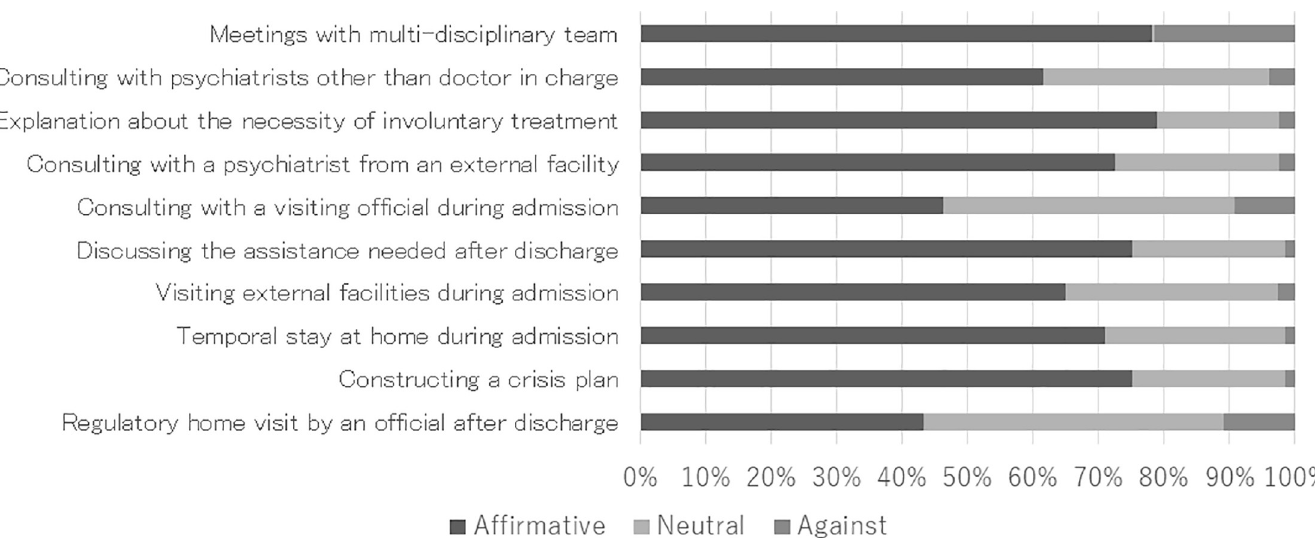
Fig 3. Opinions about assistance preferred in a future